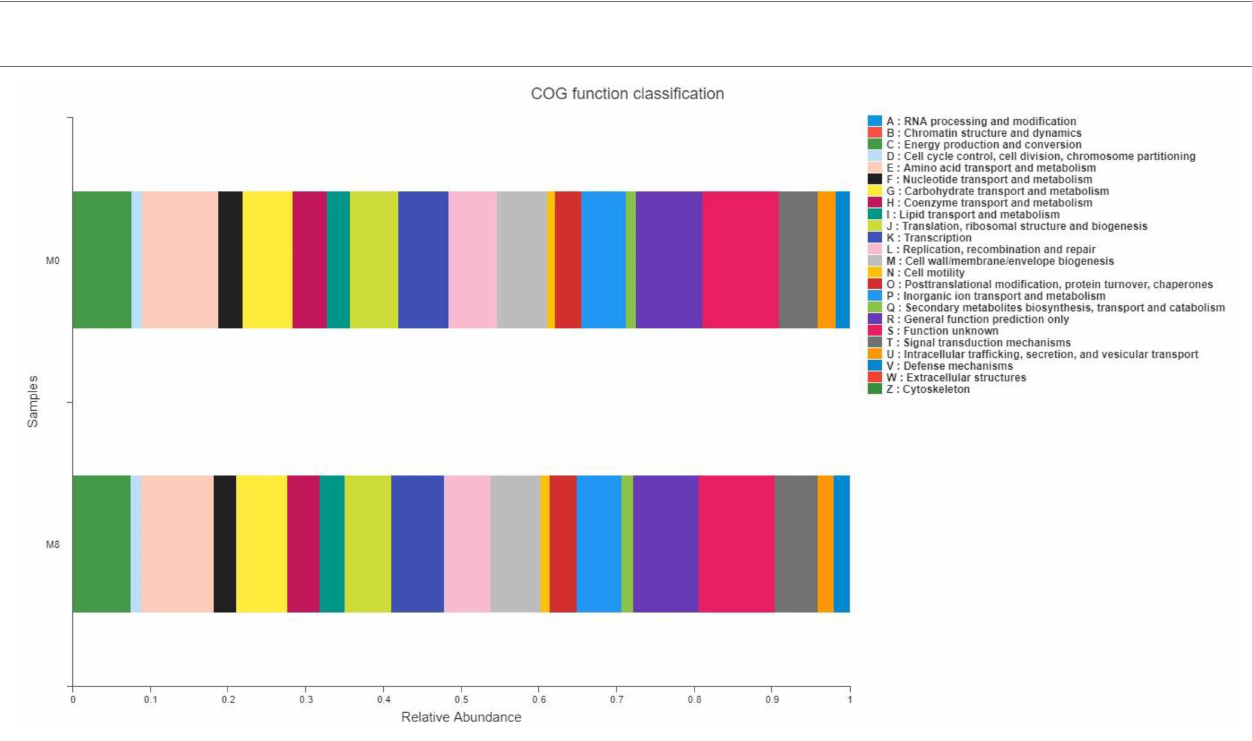
FIGURE 5 | Effects of methionine restriction on COG functional classification of gut bacteria after feeding for 8 weeks ( n =